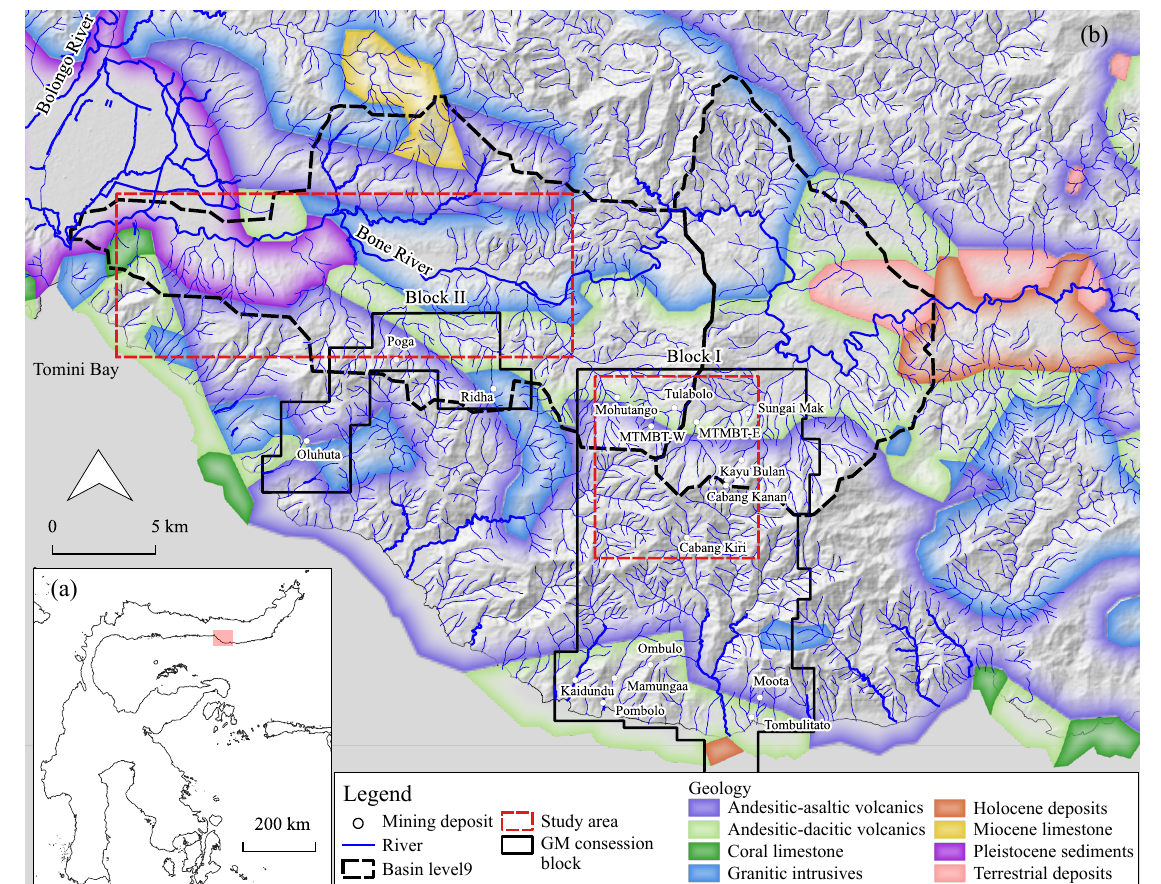
Figure 2. ( a ) Regional overview, ( b ) geological characteristics and river sub-basins in the study area overlapped with the data from the Shuttle Radar Topography Mission. The study area in the right panel corresponds to assessing the mining development. The study area in the left panel corresponds to assessing the riverbank